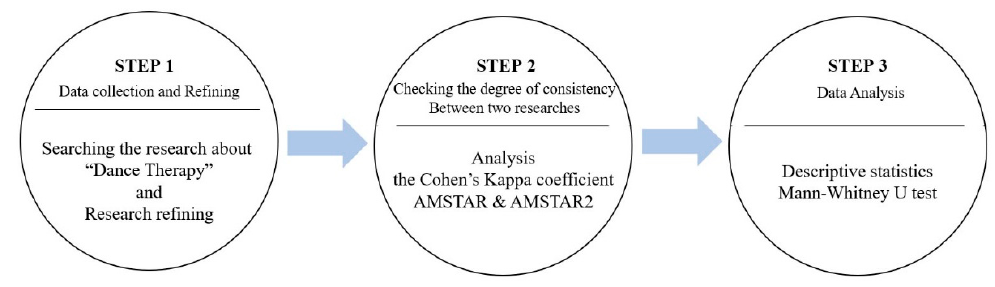
Figure 2. The overall procedure for this study.